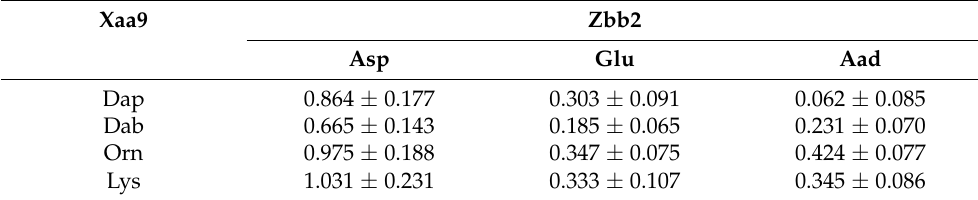
Table 4. The folding free energy ( ∆ G fold , kcal/mol) for HPDZbbXaa peptides 1 .